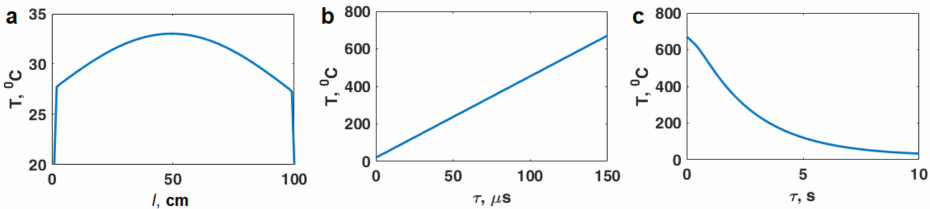
Figure 3. Thermal effect for microwave radiation of 9.4 GHz (X-band): ( a ) temperature distribution along the quarter-wave layer of the powder; ( b ) temperature dependence on the pulse duration; ( c ) temperature cooling dependence on time under the absence of